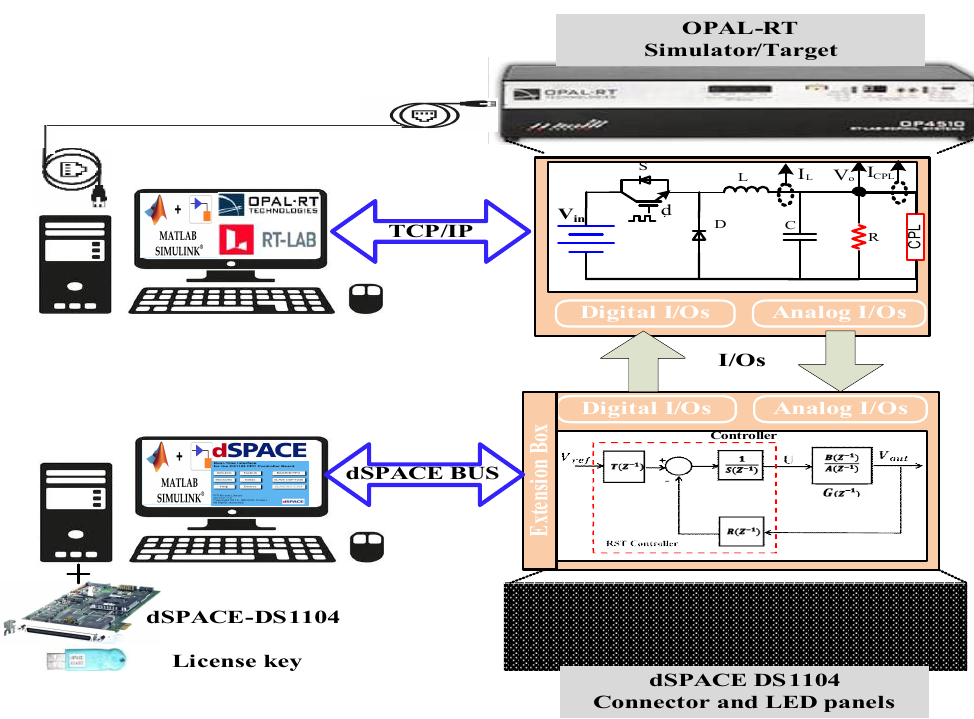
Figure 12. The experimental testbed. 1—OP4510 simulator; 2—dSPACE ds1104 Controller Box; 3—